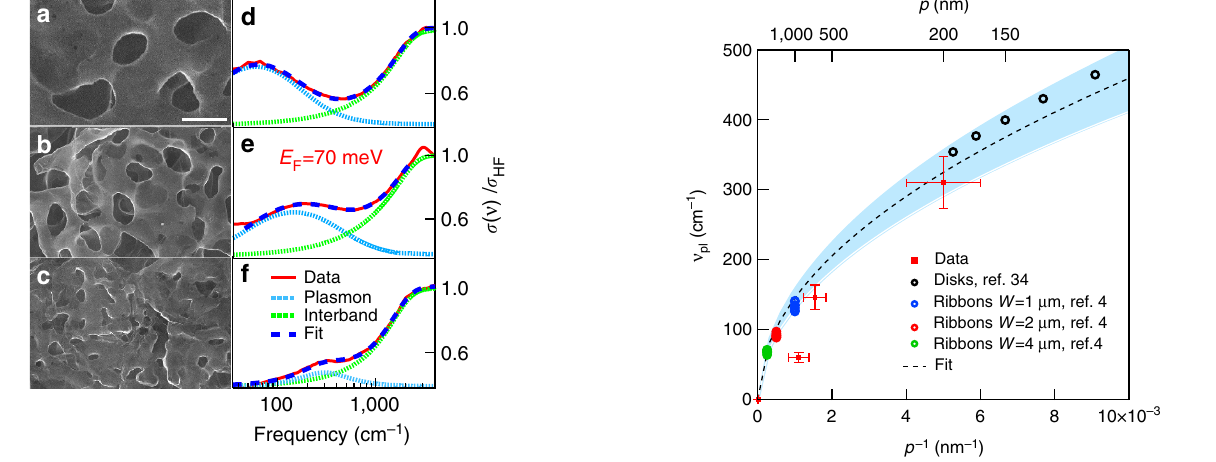
Figure 5 | The plasmon frequency versus the inverse of pore size p (cid:2) 1 . NPG experimental points (red markers) are compared with analytic calculation (black dashed line). The shaded blue area represents the effect of parameter variation on the calculation. Black empty circles (colored circles), correspond to plasmon frequency as measured in an array of nano- disks (nano-ribbons) which are rescaled to NPG data according to equation (2) to account for different Fermi energy and dielectric environment (see Methods section for details). NPG, nanoporous